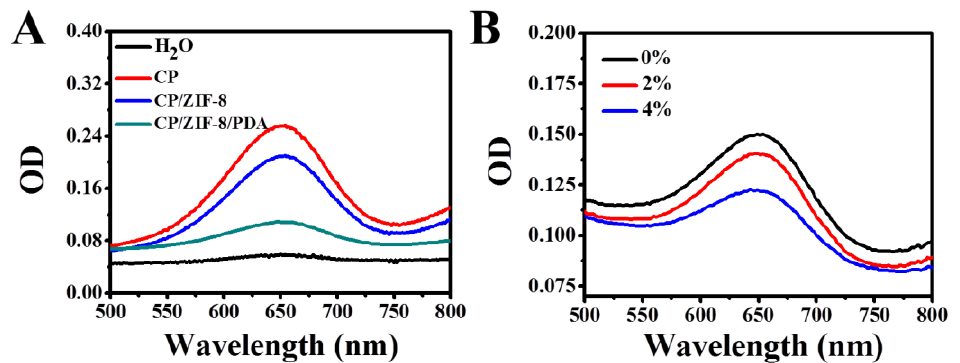
Figure 3. ( A ) Investigation of the catalytic oxidation of TMB by H 2 O, CP, CP/ZIF-8, CP/ZIF-8/PDA, ( B ) investigation of ·OH by tert-butanol as a scavenger (0/2/4% is the volume ratio of tert-butanol in the solution).